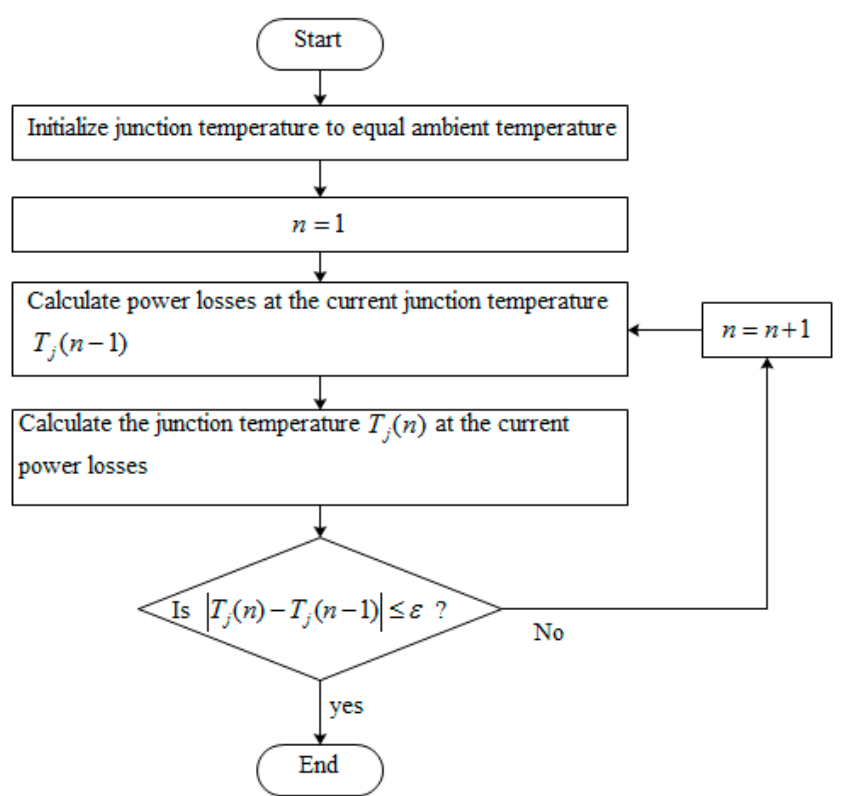
Figure 11. Flowchart of the iterative calculation of junction temperature.